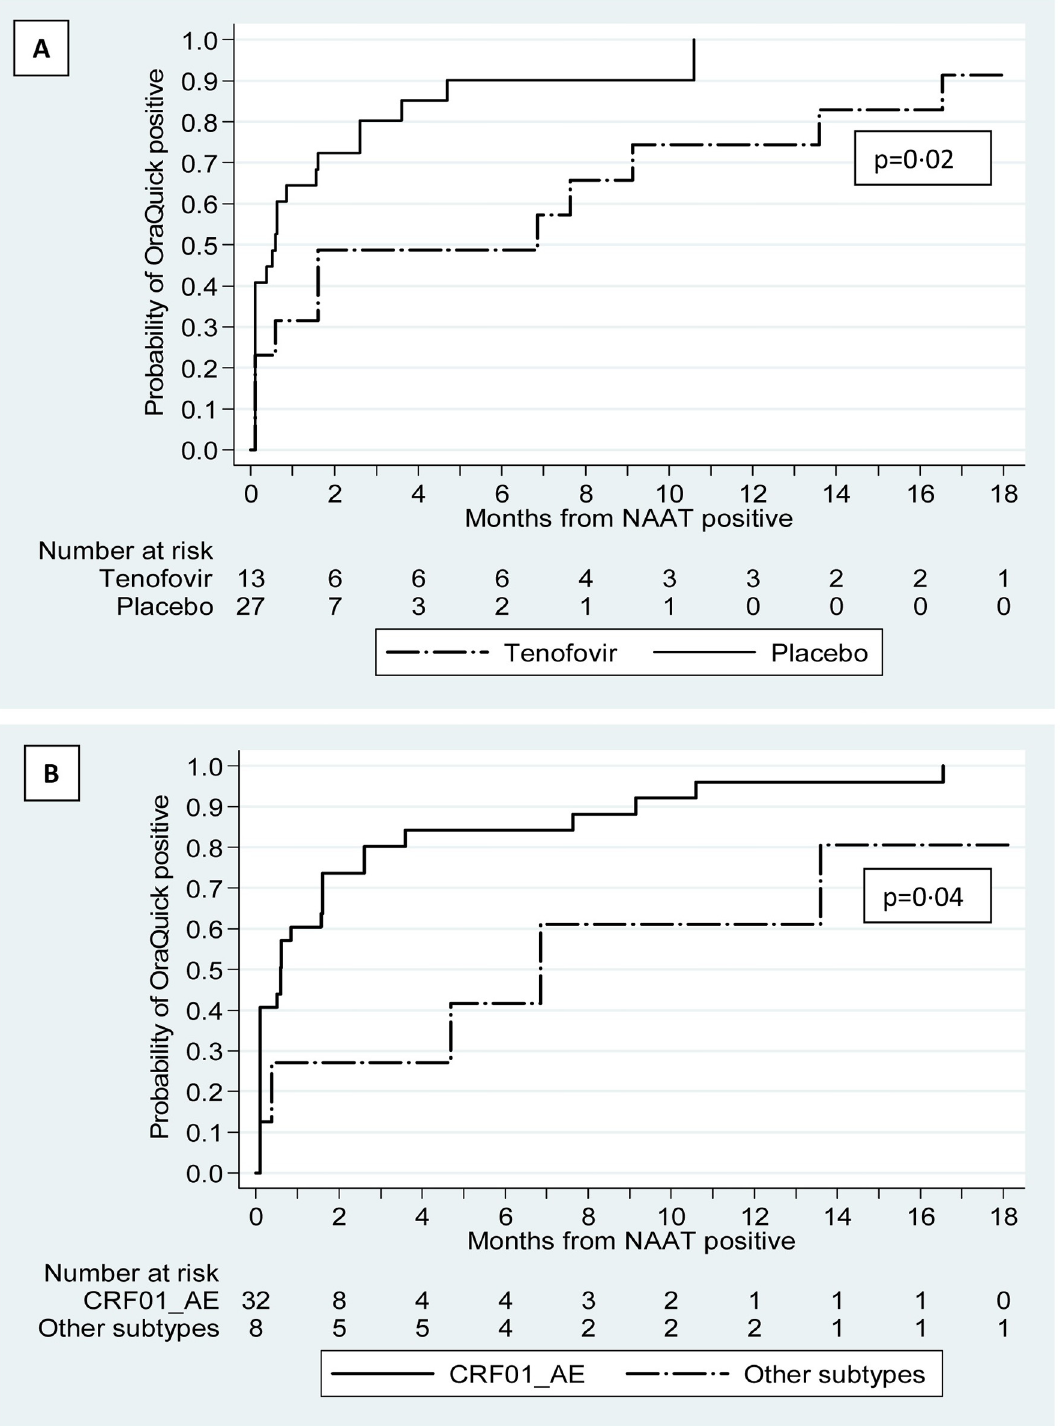
Fig 2. Kaplan-Meier estimates of time (28 day months) from date HIV was detected using nucleic acid amplification until the mid-point date between the last non-reactive and first reactive oral fluid HIV test. (A) By study drug group: tenofovir or placebo. (B) Controlling for study drug group, by HIV subtype: CRF01_AE or other